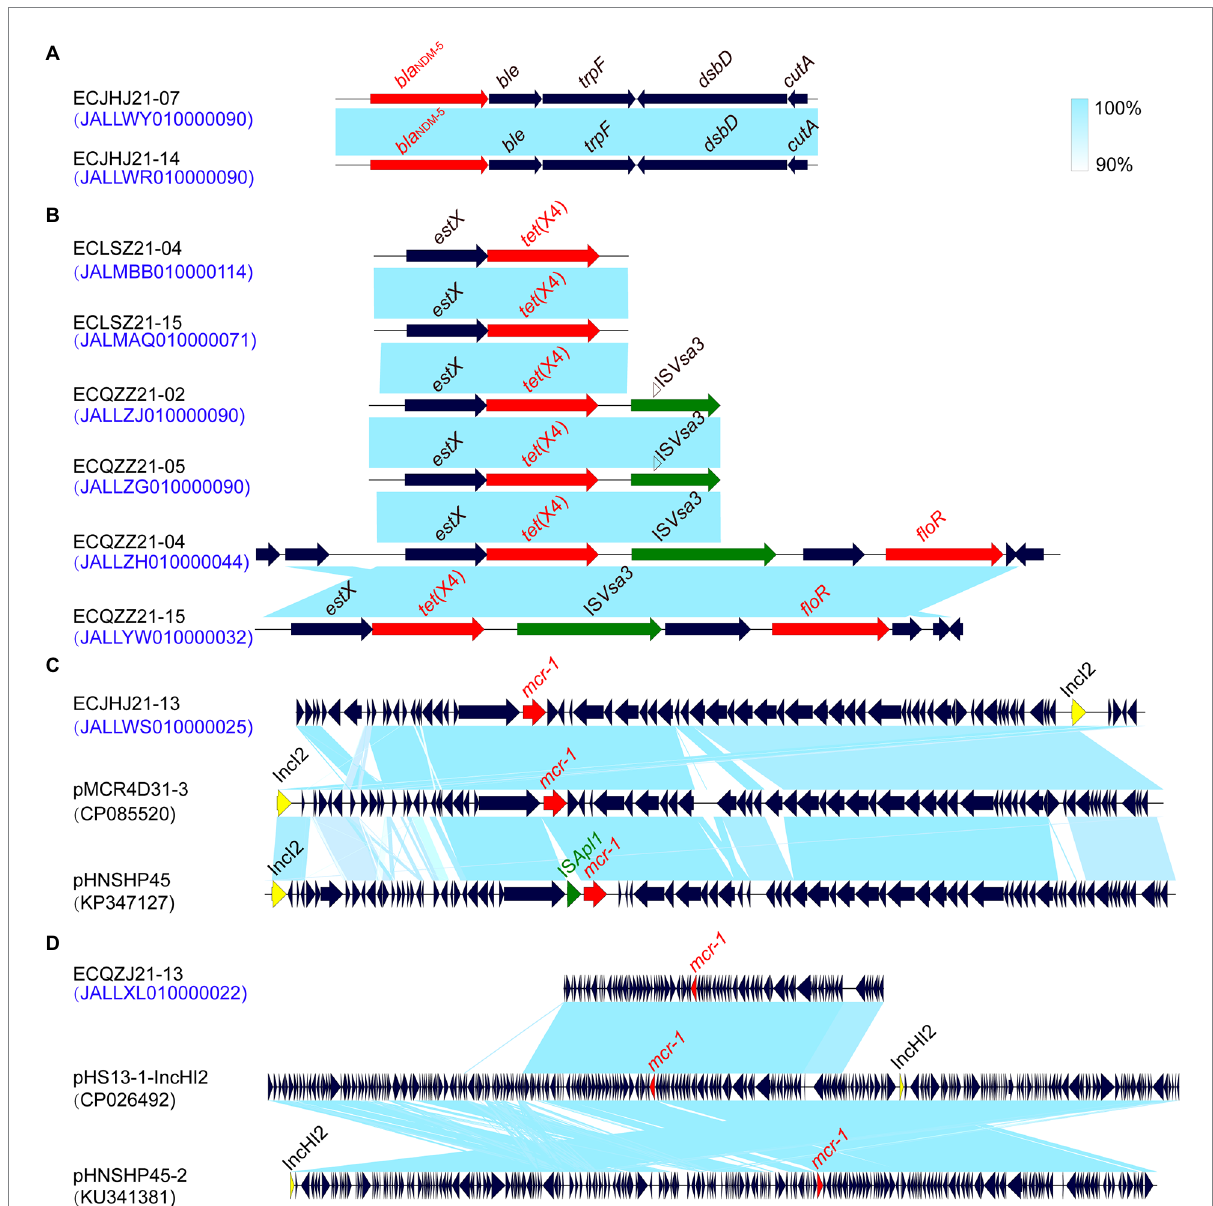
FIGURE 7 Comparison of the risk AMR gene environments in E. coli strains. (A) the bla NDM-5 gene environment. (B) the tet (X4) gene environment. (C) the mcr-1 gene environment of IncI2 plasmids. (D) the mcr-1 gene environment of IncHI2